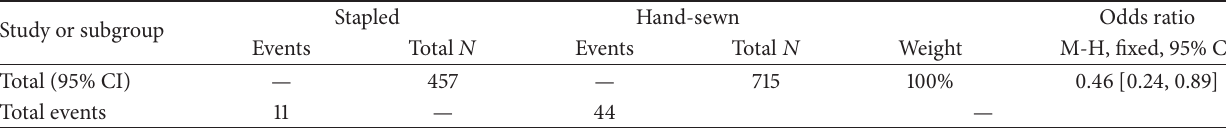
Table 4: Postoperative anastomotic leak rates between the two groups as reported in the articles included in the review. Study or